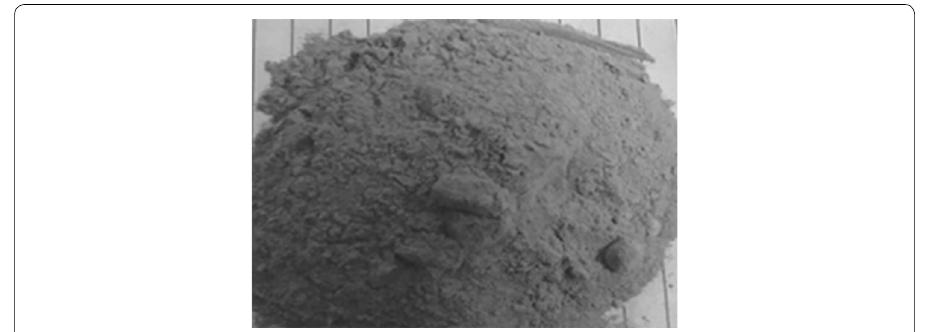
Fig. 3 Bottom ash used in present